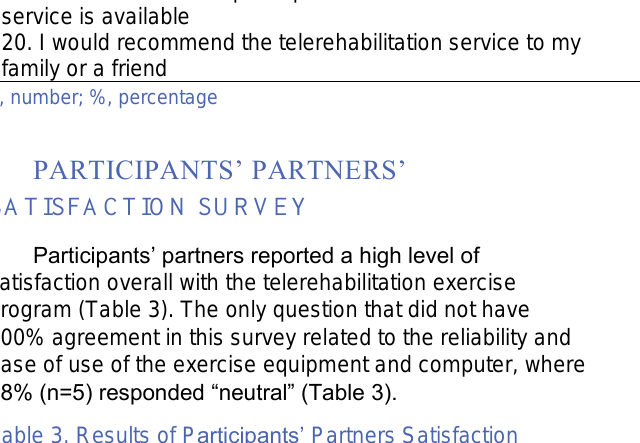
Table 3. Results of Participants’ Partners